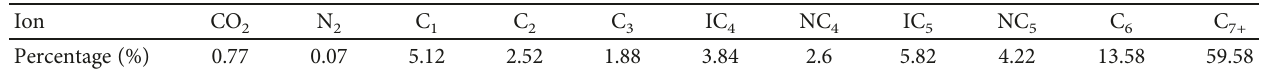
Table 3: Composition of BS8 condensate oil.